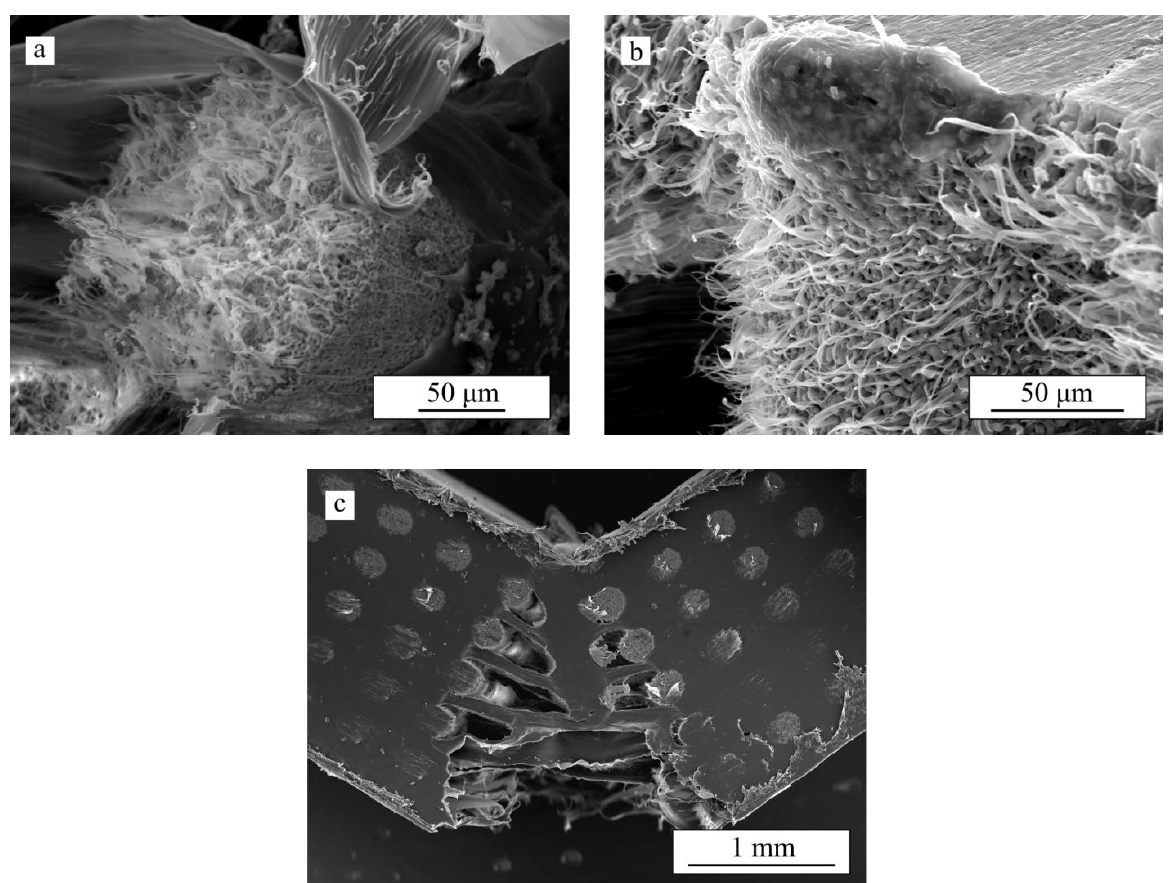
Figure 9. SEM micrographs of a TCP/PCL specimen after bending test: ( a ) fracture surface of longitudinal rods; ( b ) lateral surfaces of transversal rods; and ( c ) lateral view of the bended specimen. Both the micro- and macrofibrils are